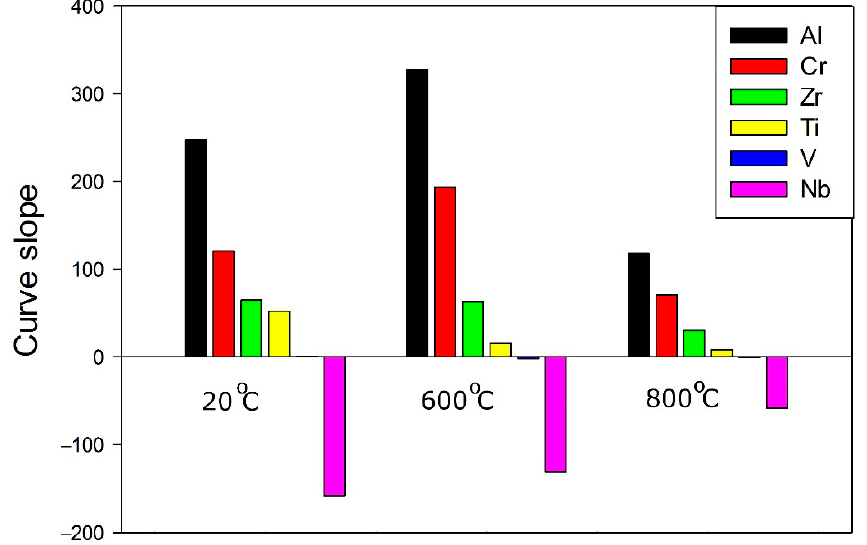
Figure 7. Slope of curves (see Figure 6) for all elements for concentrations less than 15% at 20 ◦ C, 600 ◦ C or 800 ◦ C.